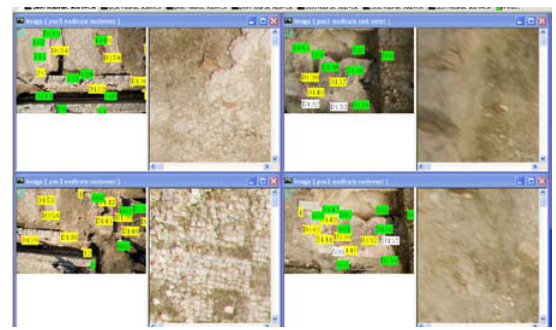
Figure 2. Some views showing the shooting geometry scheme (top), and a screen shot of the matching results (TIN textured visualization) for the test area (Photomodeler